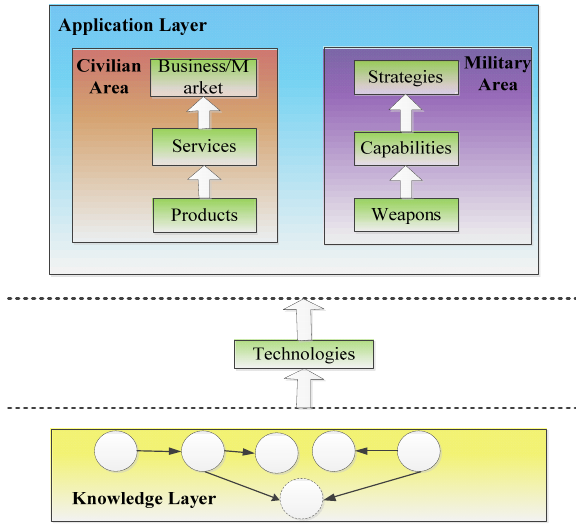
Figure 1. Evolution routes of technology development.